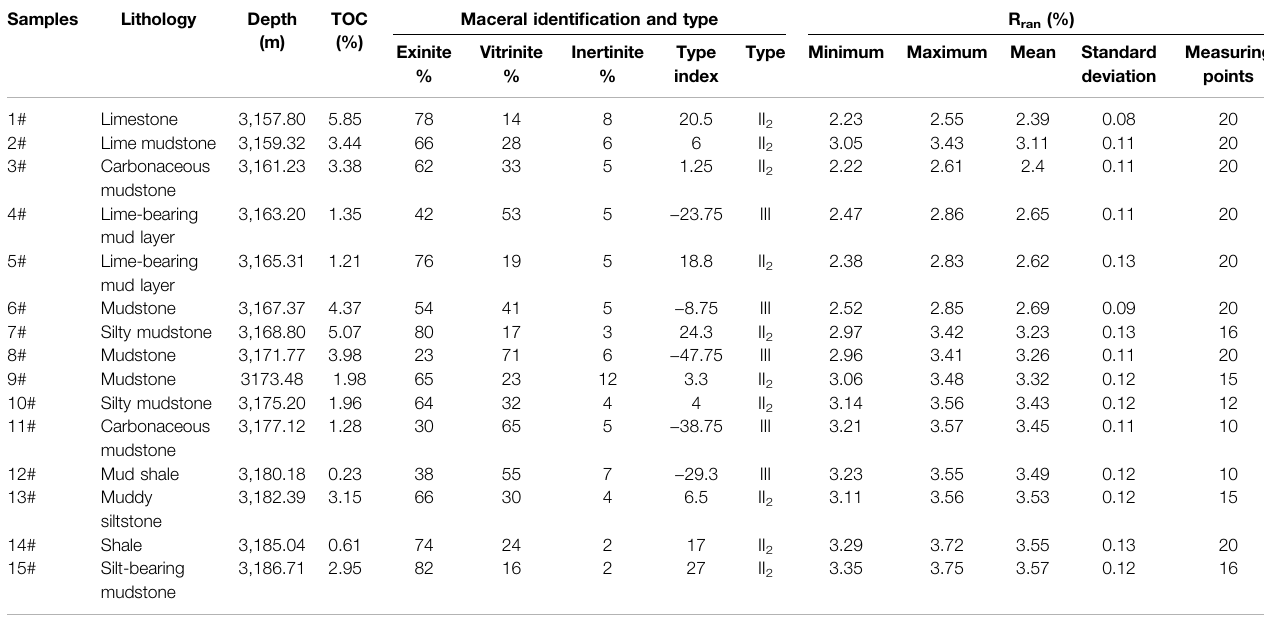
TABLE 1 | Types of kerogen and re fl ectance of Longtan Formation samples. Samples